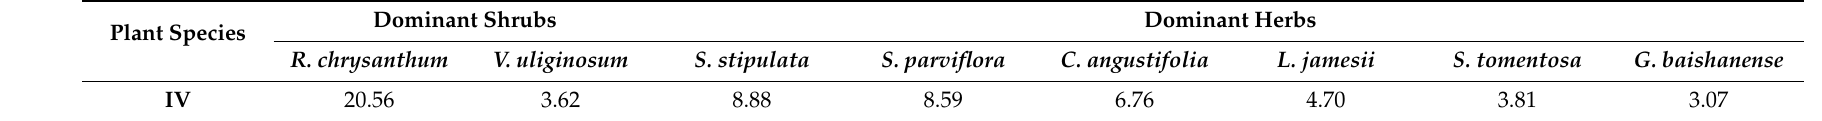
Table 1. Important value index (IV) of the eight dominant species.